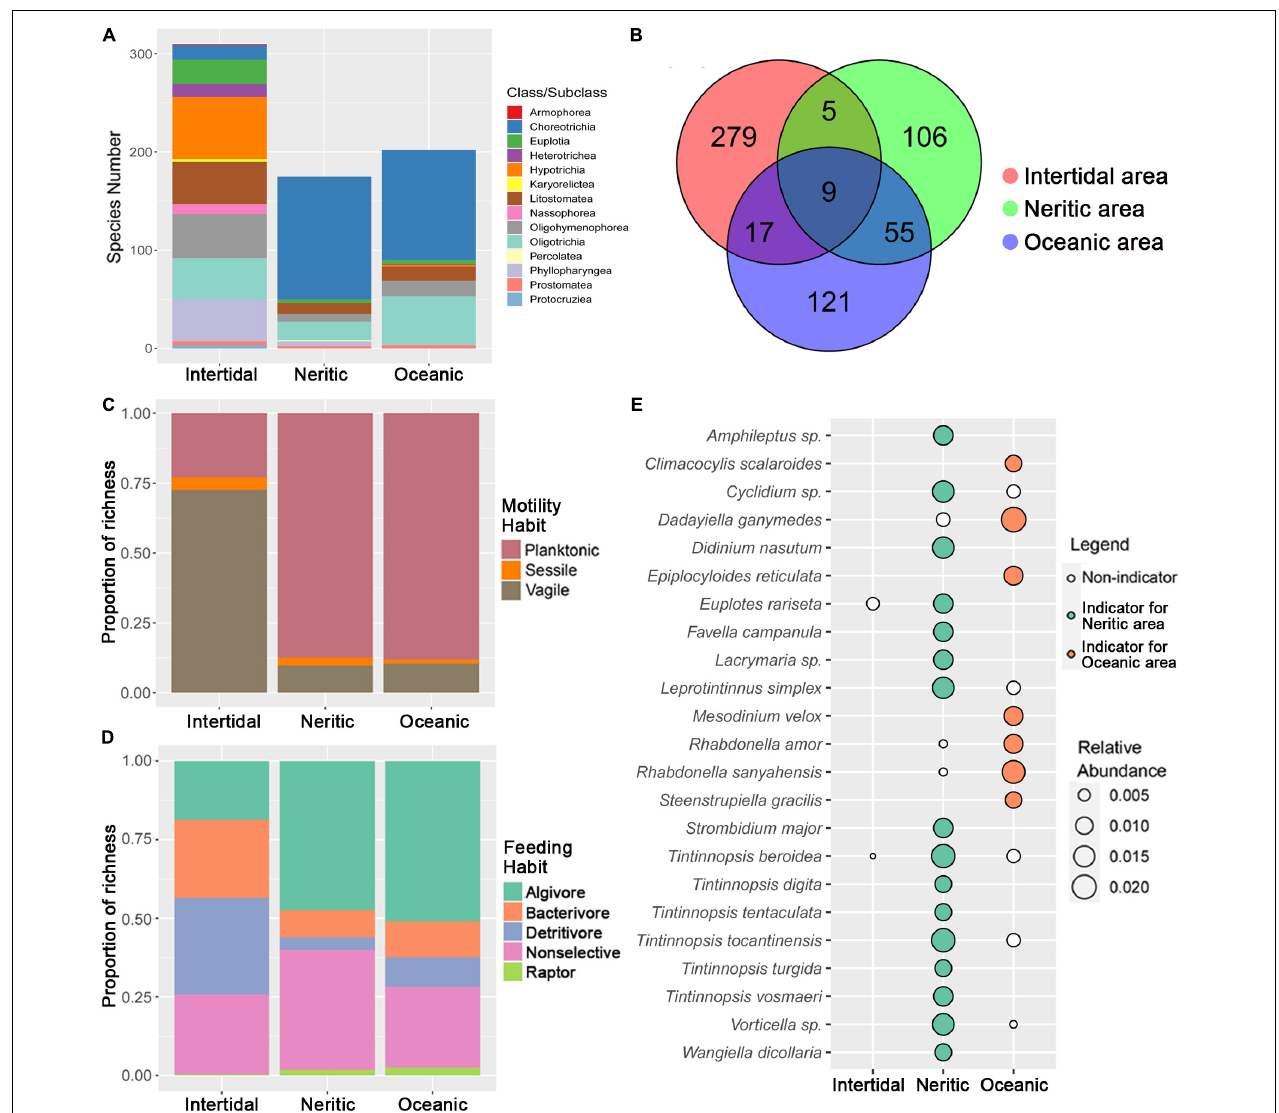
FIGURE 1 | Comparison of ciliate diversity and composition among the three areas in SCS. (A) Taxonomy composition patterns of ciliates at class/subclass level in the three areas. (B) Venn diagram showing the number of species that are unique and shared among the three areas. (C) Proportion of motility habit grouping of ciliates in the three areas. (D) Proportion of feeding habit grouping of ciliates in the three areas. (E) Indicator species in the three areas (no indicator species was identified in the Intertidal area); the size of the bubble indicates the relative abundance of each species in each